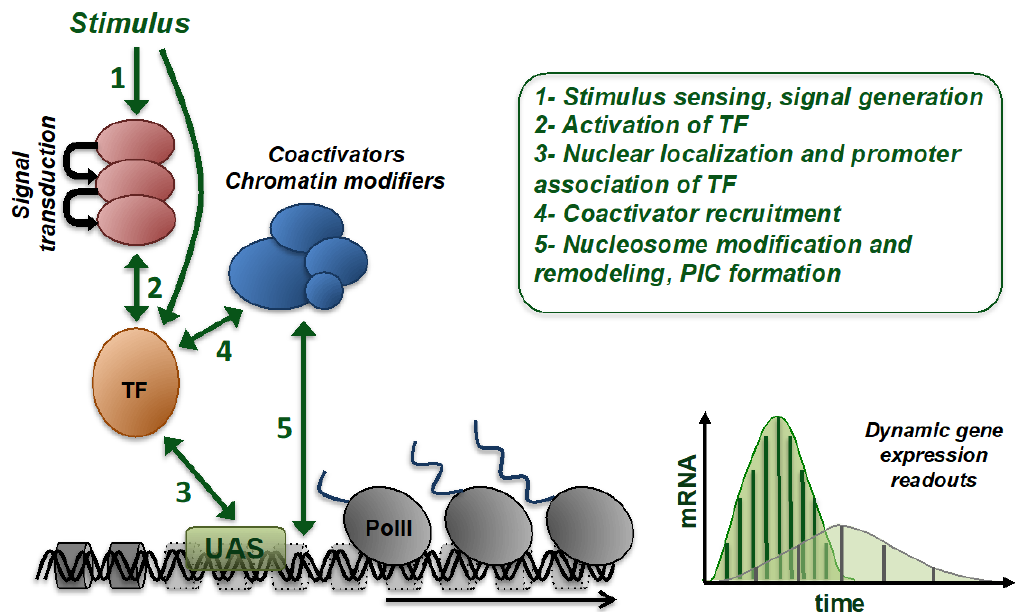
Figure 1. Determinants of dynamic transcriptional regulation of eukaryotic genes. Schematically are shown the processes that can modulate the timing and efficiency of activated gene expression. A given stimulus can give rise to different gene expression patterns in a gene- and cell-specific manner. TF, transcription factor, UAS, upstream activating sequence, PolII, RNA polymerase II, PIC, preinitiation complex.